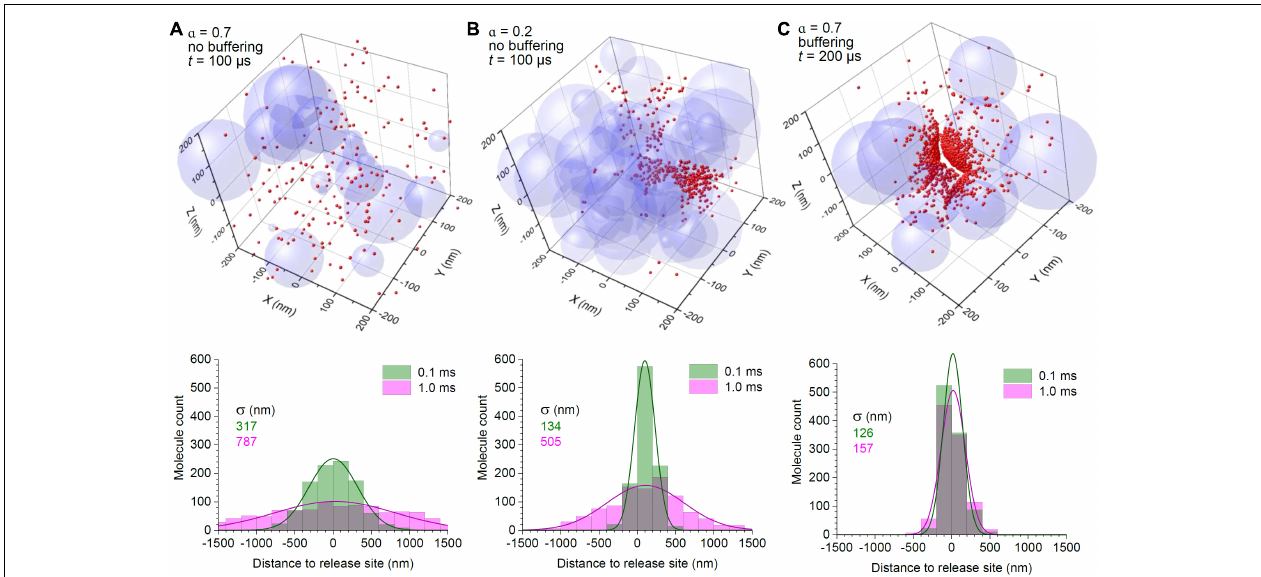
FIGURE 1 | Surface binding to high-affinity transporters provides efficient control of extrasynaptic glutamate escape even in high-porosity tissue. (A) 3D graph: A snapshot of the simulated molecular scatter (400 nm wide fragment of the 3 µ m wide simulation arena), 0.1 ms after release of 2,000 particles in the centre, with a scatter of overlapping spheres representing 3D obstacles to diffusion; α = 0.7, medium porosity (volume fraction of the free space). Histogram: spatial distribution of diffusing particles across the simulation arena, at two time points post-release, as indicated; solid lines, best-fit Gaussian distribution; σ , distribution dispersion (standard deviation). (B) Simulations as in (A) , but with medium porosity α = 0.2; note that the particle scatter is skewed because of the asymmetric geometry of diffusion obstacles (sphere aggregates); other notations as in (A) . (C) Simulations as in (A) , but with the particle-surface binding enabled; particle catchment occurs at a distance of ± 3 nm of the surface, to reflect the elementary diffusion displacement (cid:49) 1 D (see section “Methods”); other notations as in (A) .